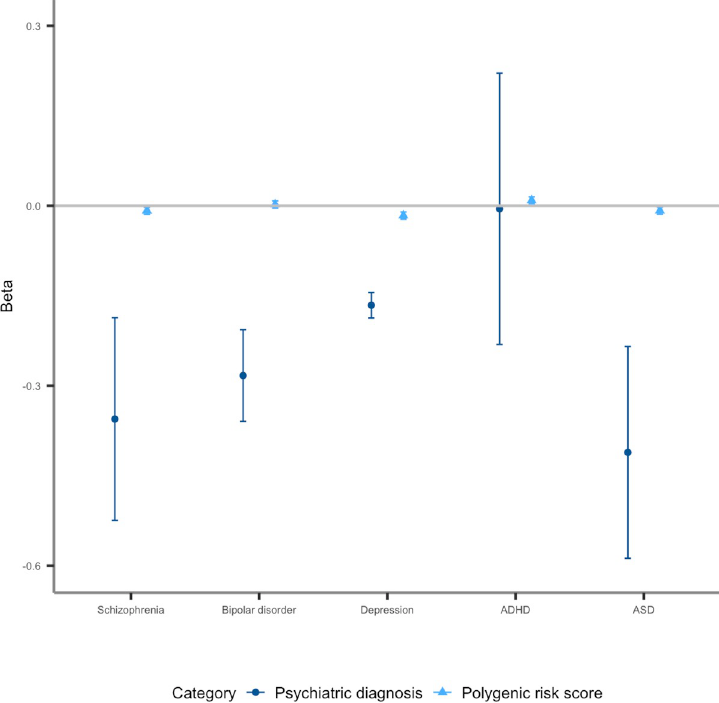
Fig 1. The effect size (beta) for associations between overall activity and diagnoses of, and PRS for, each psychiatric disorder. Error bars indicate 95% confidence intervals. A beta of 1 is equivalent to a 1 standard deviation (SD) change in level of activity between individuals with and without a psychiatric disorder or per 1 SD increase in PRS. We excluded individuals with a psychiatric disorder for PRS analyses.